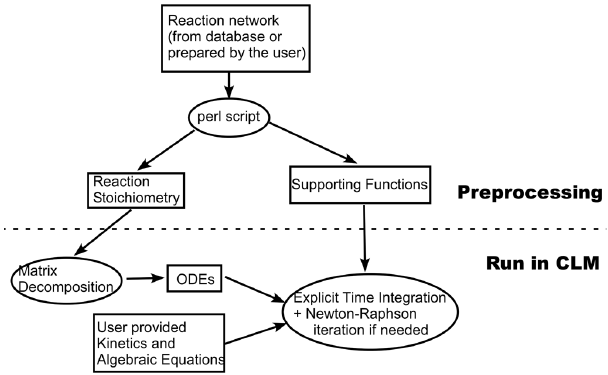
Fig. 2. Diagram of model structure. Rectangles represent model in- put/output, ovals represent executable